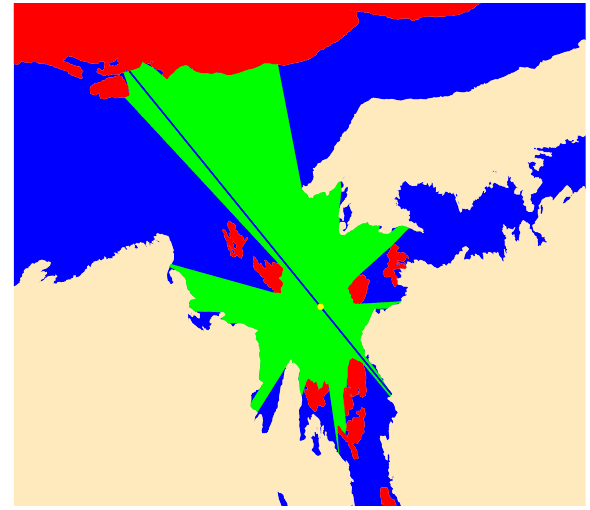
Figure 10. The navigable/visible area in green generated using Isovist for Type CAC3 ship, where the yellow point is the current position.